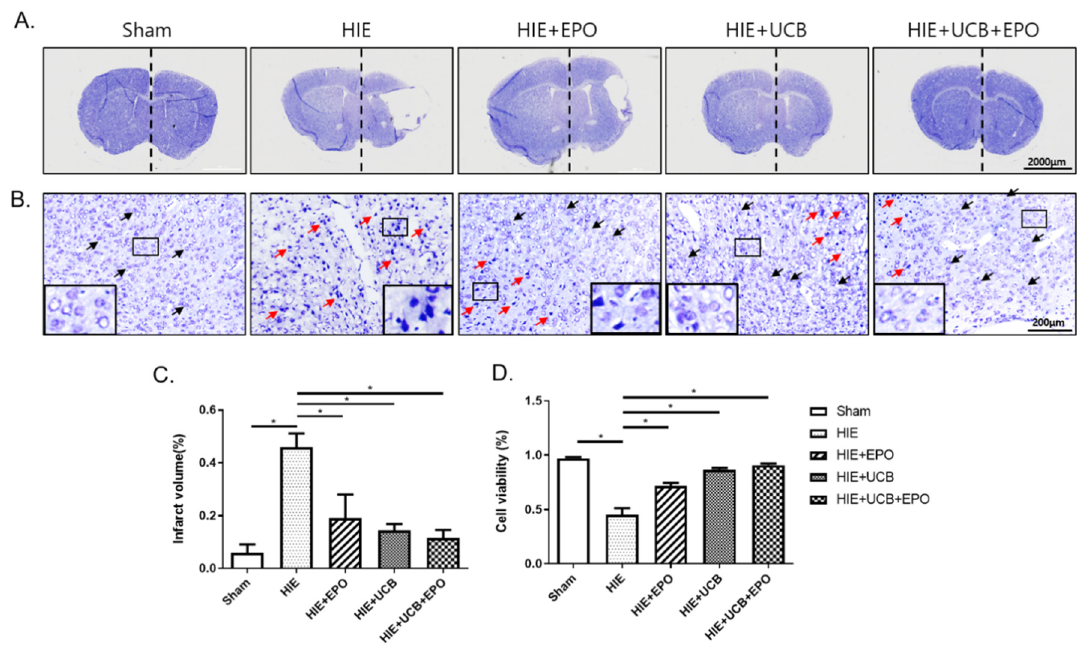
Figure 2. Attenuation of brain damage and prevention of neuronal cell death in brains of HIE model in each treatment group. ( A ) Whole brain sections were stained with cresyl-violet and ( C ) the graph depicts the total volume of the infarct size in the affected hemisphere, which was estimated in comparison with that in the contralateral side by the ImageJ program. ( B ) The enlarged images show the morphology of the neuronal cell. Normal cells are indicated with black arrows and abnormal cells with red arrows. ( D ) The graph depicts the cell viability by the percentage of neuronal cells after each treatment group. Data shown as the mean ± standard error of mean. n = 3 per group. * p < 0.05 (one-way ANOVA).